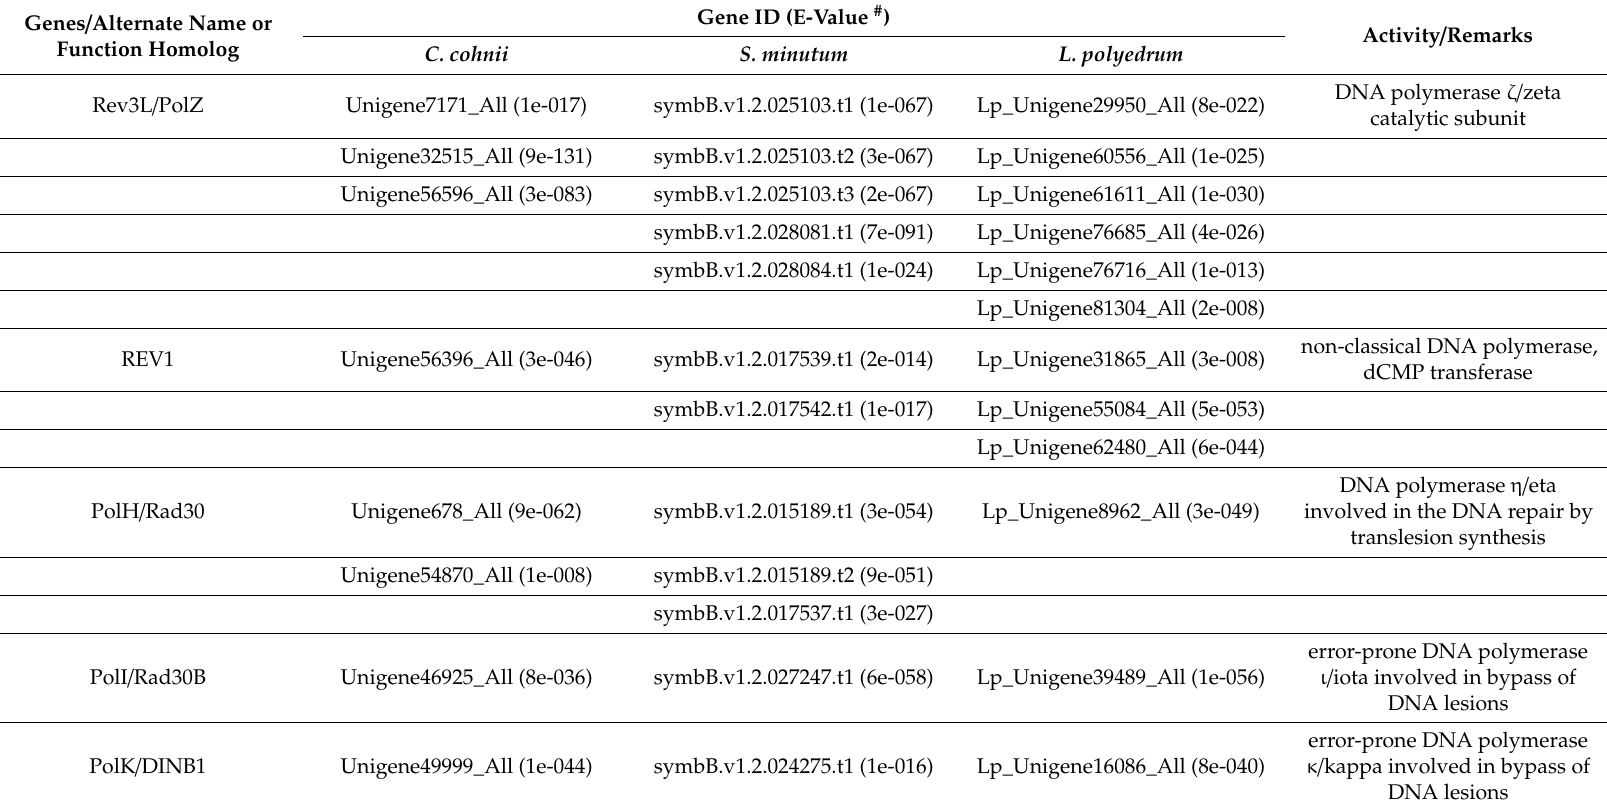
Table 8. Dinoflagellate orthologues predicted in translesion